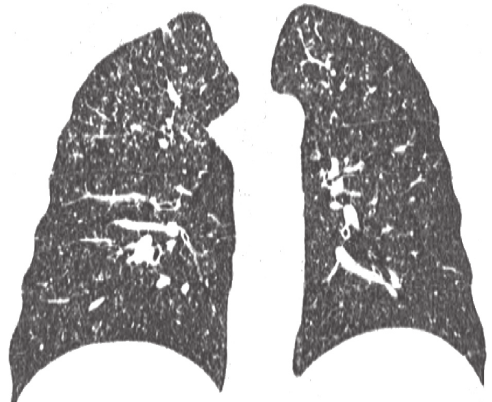
Figure 4: Coronal plane chest CTwith the presence of innumerable small (2–4 mm) pulmonary nodules with a centrilobular predi- lection, consistent with miliary